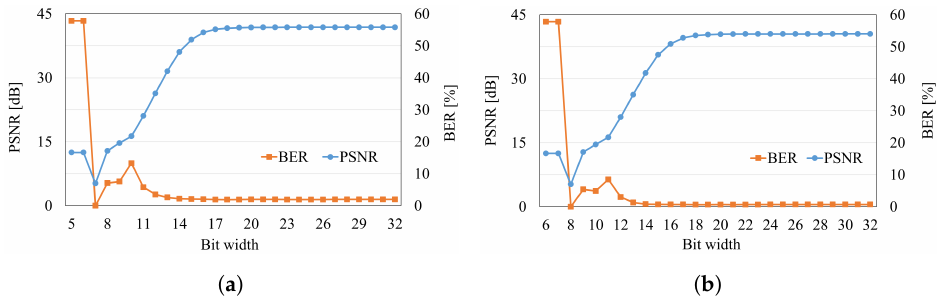
Figure 6. Precision analysis of the weight number system: ( a ) 3 bits for integer part, ( b ) 4 bits for integer part.